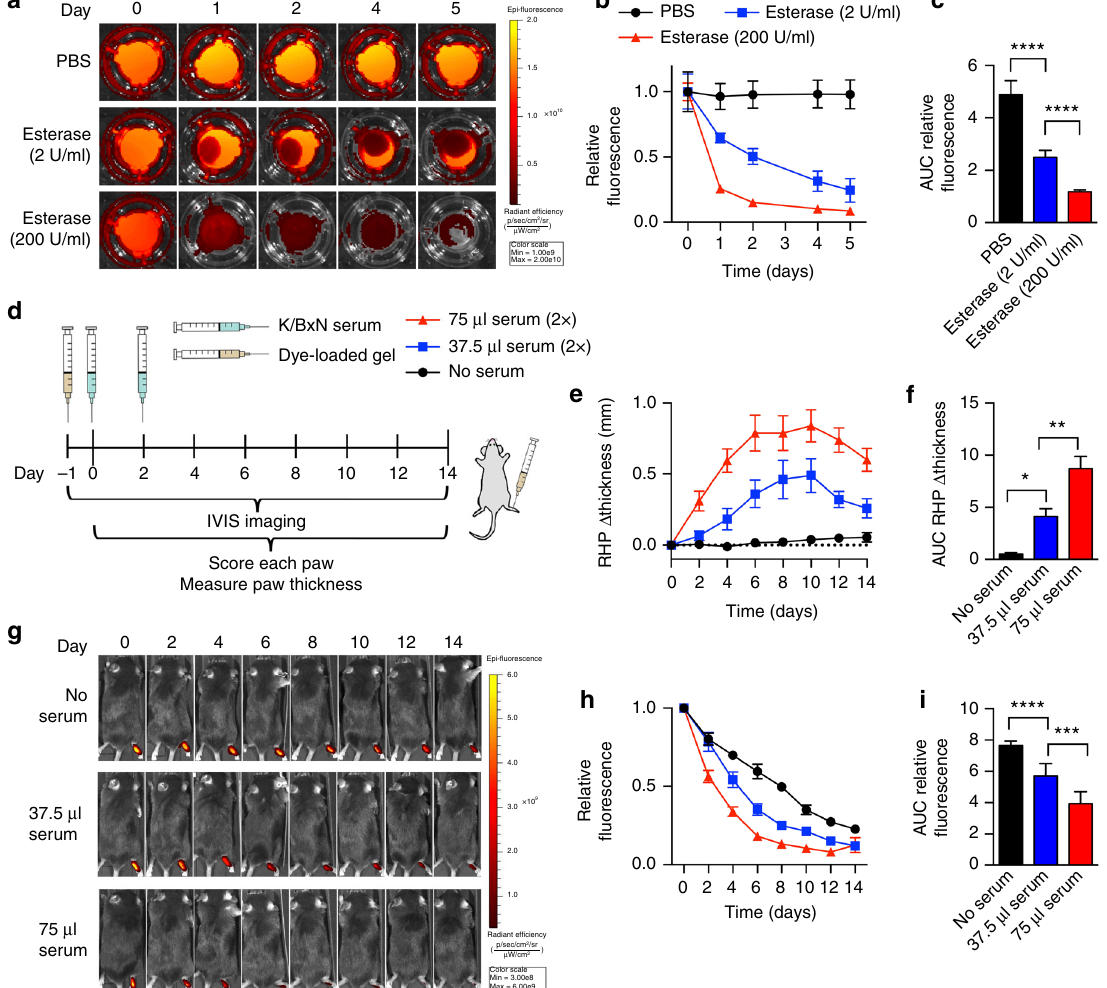
Fig. 4 TG-18 hydrogel disassembly correlates with arthritis severity. a DiR-loaded hydrogels were incubated in PBS without or with esterase ( T. lanuginosus lipase, 2 or 200 U/ml). To quantify fl uorescence signals at each time point, transwell inserts with hydrogel were temporarily removed from the plate and placed on a new plate for imaging using an in vivo imaging system (IVIS). Images of a representative well from each experimental group are shown. b , c Relative fl uorescence curves (normalized to day 0) for hydrogels inclubated without or with esterase and their area under the curves (AUCs) (**** P < 0.0001). d Experimental outline: Mice were injected with fl uorescent dye-loaded hydrogel (4 µ l) into the right hindpaw (RHP) on day − 1. Arthritis